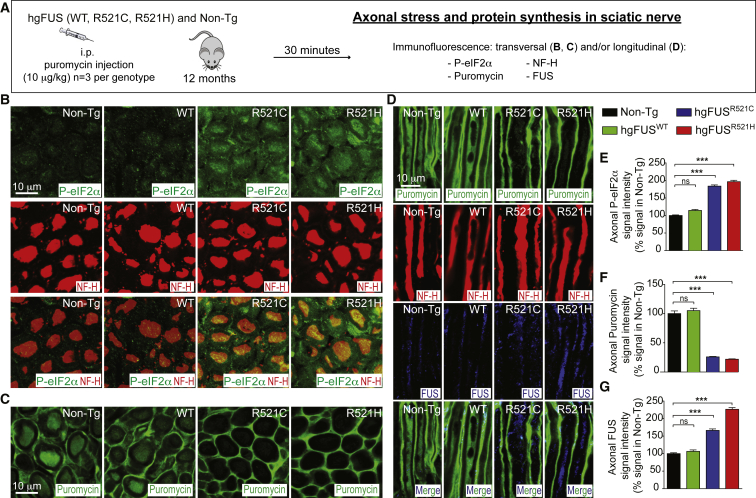
ALS-Linked Mutations in FUS Cause Stress-Mediated Reduction in Local Axonal Protein Synthesis within Sciatic Nerve Axons of Mutant FUS Mice(A) Experimental design to assess stress and local axonal translation in the sciatic nerve of 12-month-old Non-Tg, hgFUSWT, hgFUSR521C, and hgFUSR521H mice.(B) Transversal sections of mouse sciatic nerves immunostained using P-eIF2α (green) and NF-H (red) antibodies and (C) puromycin (green) antibody.(D) Longitudinal sections of mouse sciatic nerves immunostained using puromycin (green), NF-H (red), and FUS (blue) antibodies. Scale bars, 10 μm.(E–G) Quantification of the relative fluorescence intensity of the (E) P-eIF2α, (F) puromycin, and (G) FUS immunostainings within sciatic nerve axons of 12-month-old Non-Tg, hgFUSWT, hgFUSR521C, and hgFUSR521H mice. The bar graph represents mean ± SEM (n = 3 animals per group). ∗∗∗p < 0.001, two-sided unpaired Student’s t test.